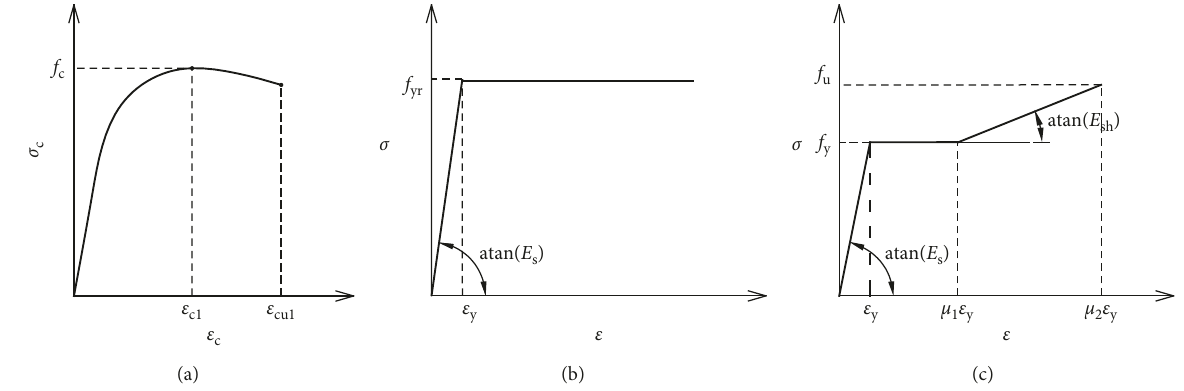
Figure 4: Constitutive relations for (a) concrete, (b) reinforcement, and (c)